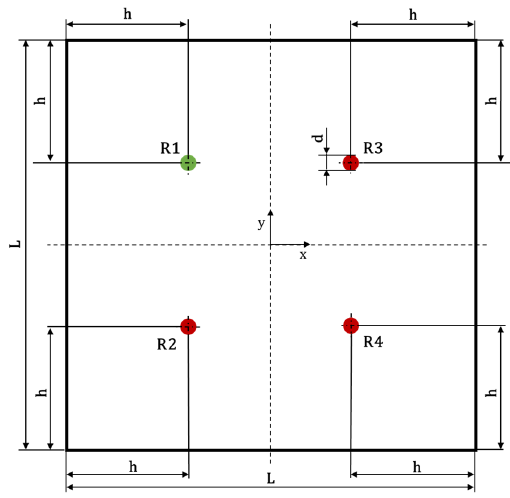
Figure 1. Panel geometry and sensors position.